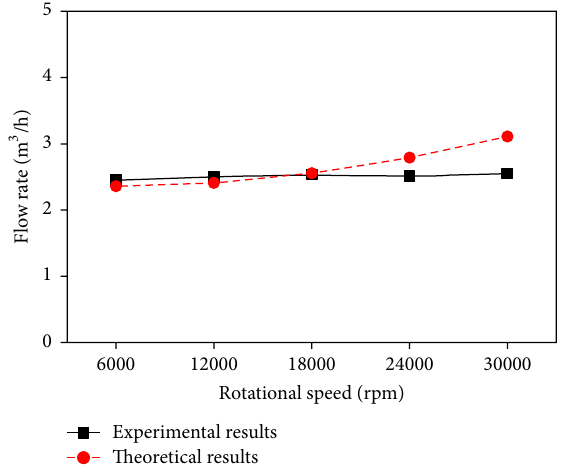
Figure 4: Flow rate versus rotational speed at a supply pressure of 2.5 MPa.